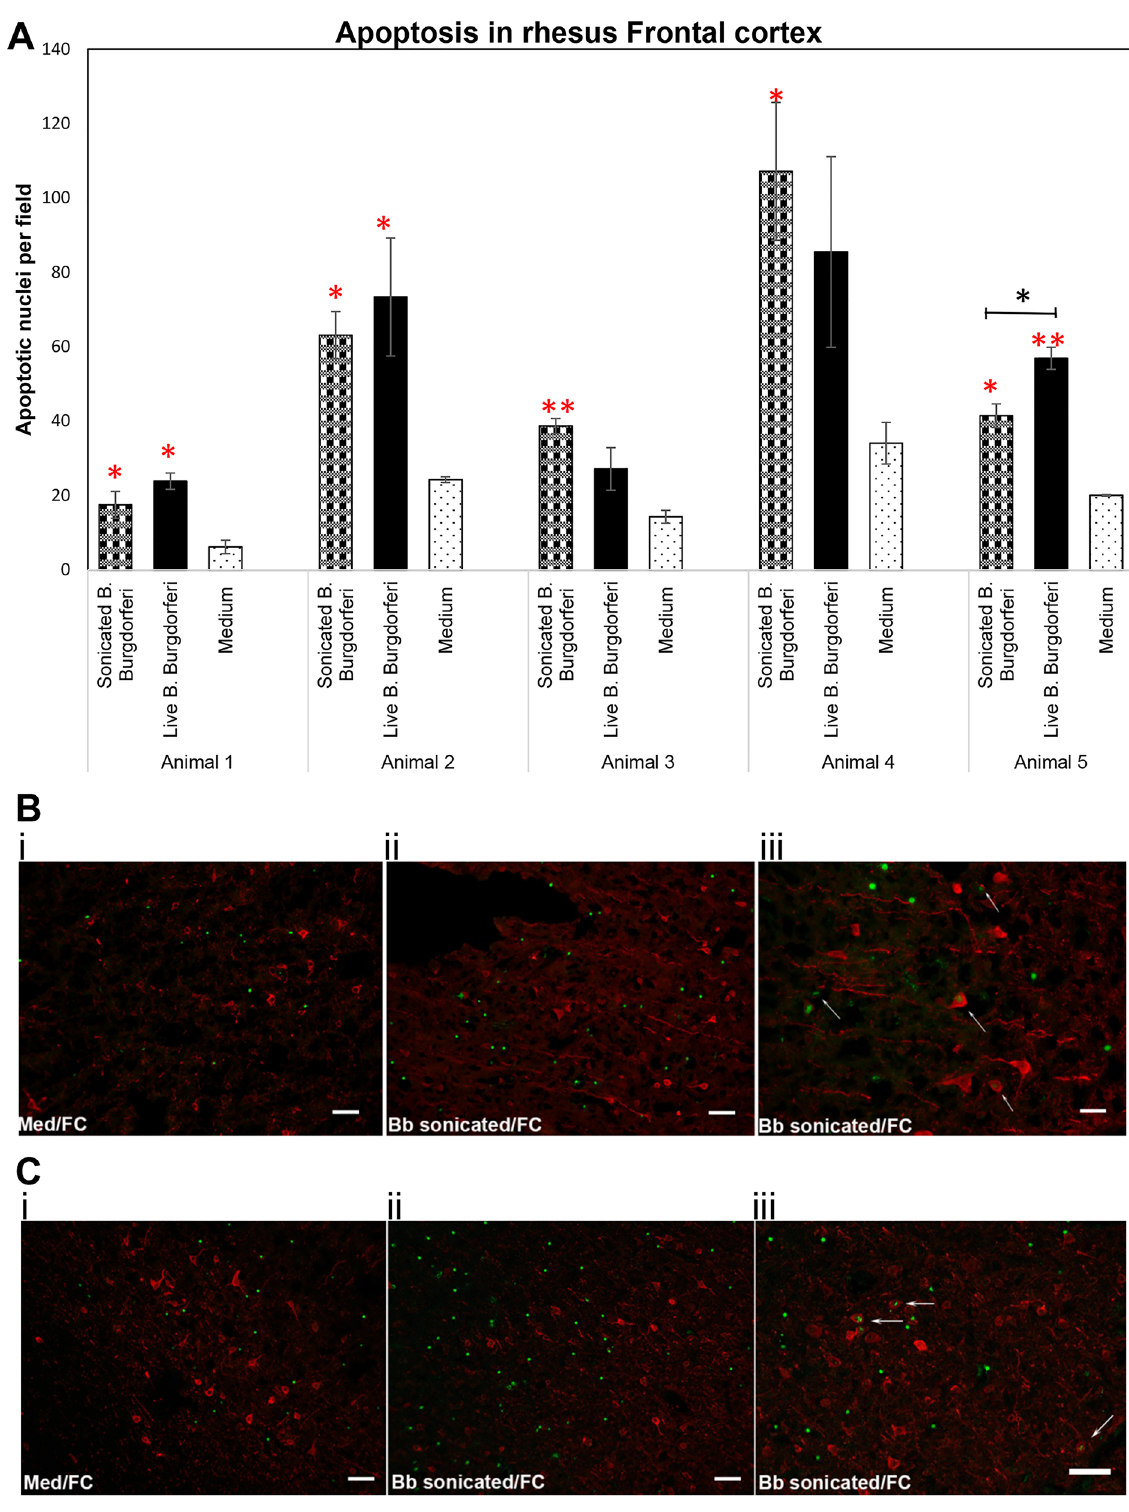
Figure 5. Non-viable B. burgdorferi mediates cell death in the rhesus FC. Rhesus frontal cortex tissues were exposed to live or sonicated B. burgdorferi for 4 h. TUNEL assays were carried out on cryosections as described in Materials and methods. Results from 5 different animal tissues is shown in ( A ). Bars represent standard deviation. Red asterisks indicate significantly higher levels of apoptosis compared to tissue sections exposed to medium alone. Black asterisk shows significantly higher level of apoptosis in tissues exposed to live B. burgdorferi compared to sonicated bacteria in that animal tissue. ***p < 0.001; **p < 0.01; *p < 0.05. Immunofluorescence photographs of TUNEL assays from Animal 1 ( B ) and Animal 2 ( C ). i and ii show the overall difference in apoptotic nuclei (green) between tissue sections exposed to Medium (i) and sonicated bacteria (ii). (iii) shows apoptotic nuclei within MAP2 stained (red) neurons indicated by white arrows. Bar represents 50 µm except for B iii (25